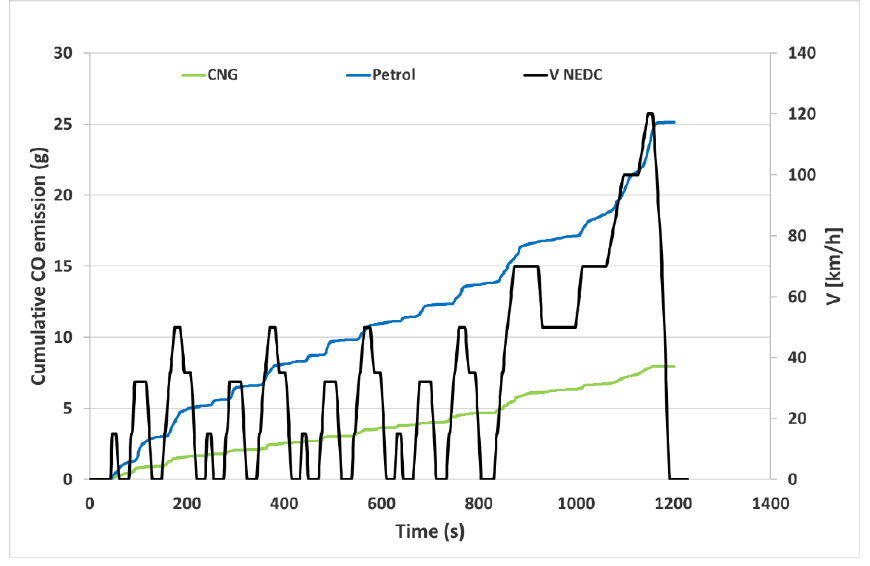
Figure 8. Cumulative CO emissions of a vehicle fueled with petrol and CNG for the NEDC test.